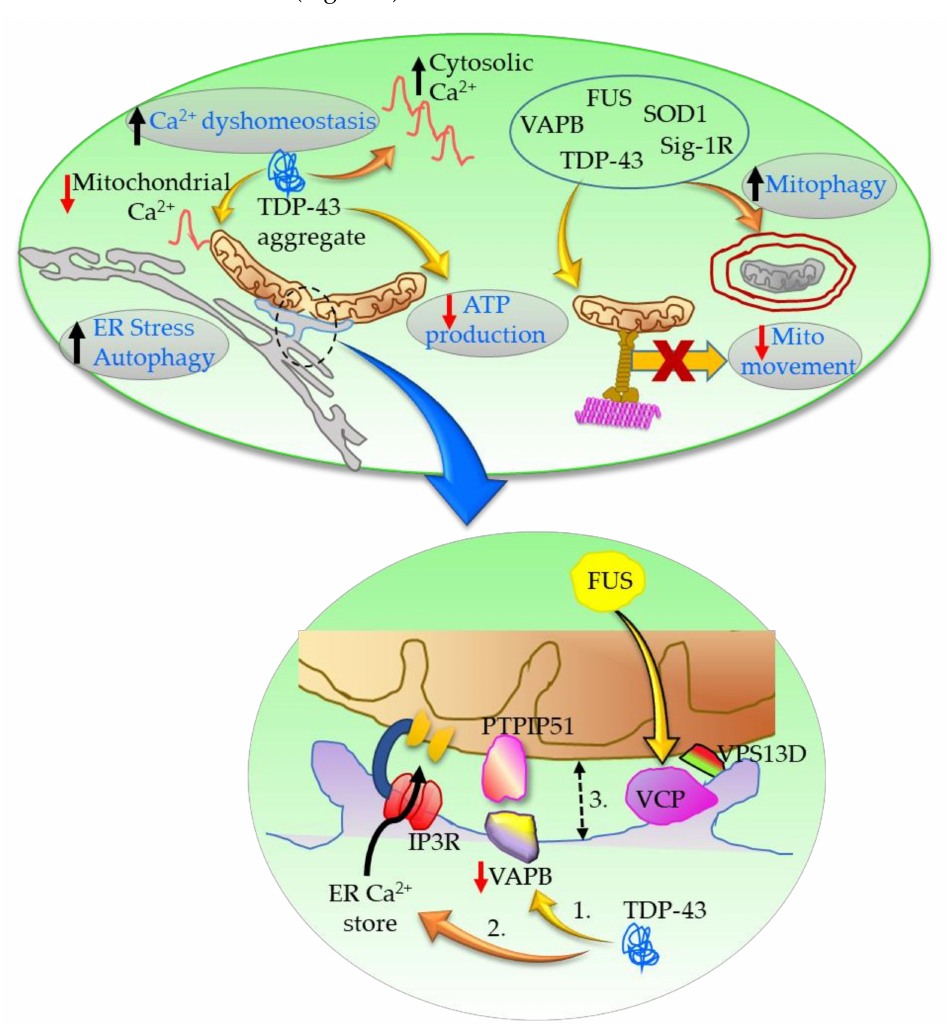
Figure 3. VAPB-PTPIP51 binding regulates ER–mitochondria associations in response to Ca 2+ . In ALS: 1. TDP-43 reduces the amount of VAPB bound to PTPIP51; 2. TDP-43 produces Ca 2+ dyshomeostasis following IP3R-mediated Ca 2+ release from ER stores; 3. TDP-43 thus decreases ER–mitochondria associations. Ca 2+ dyshomeostasis further results in reduced mitochondrial ATP production, impaired anterograde transport of mitochondria, and increased autophagy and ER stress. FUS interacts with VCP and alters VCP–vacuolar protein sorting-associated protein 13D (VPS13D) interactions at the MAM. Furthermore, TDP-43, SOD1, FUS, VAPB, and Sig-1R interact at the MAM to increase mitochondrial fission resulting in mitochondria with decreased membrane potential, and thus increase